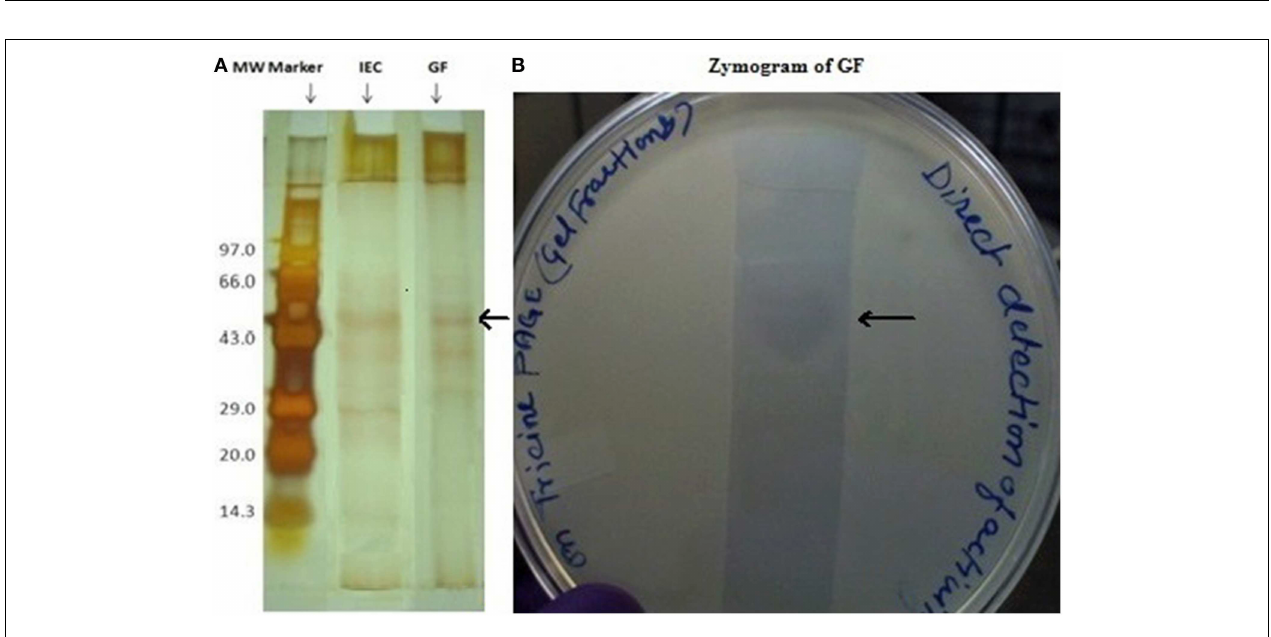
(IEF) and lane 4 gel filtration fractions (GF). The arrow shows the band that showed in-gel inhibition in a zymogram assay. (B) Zymogram (right side) of the gel-filtration purified fraction after concentration.